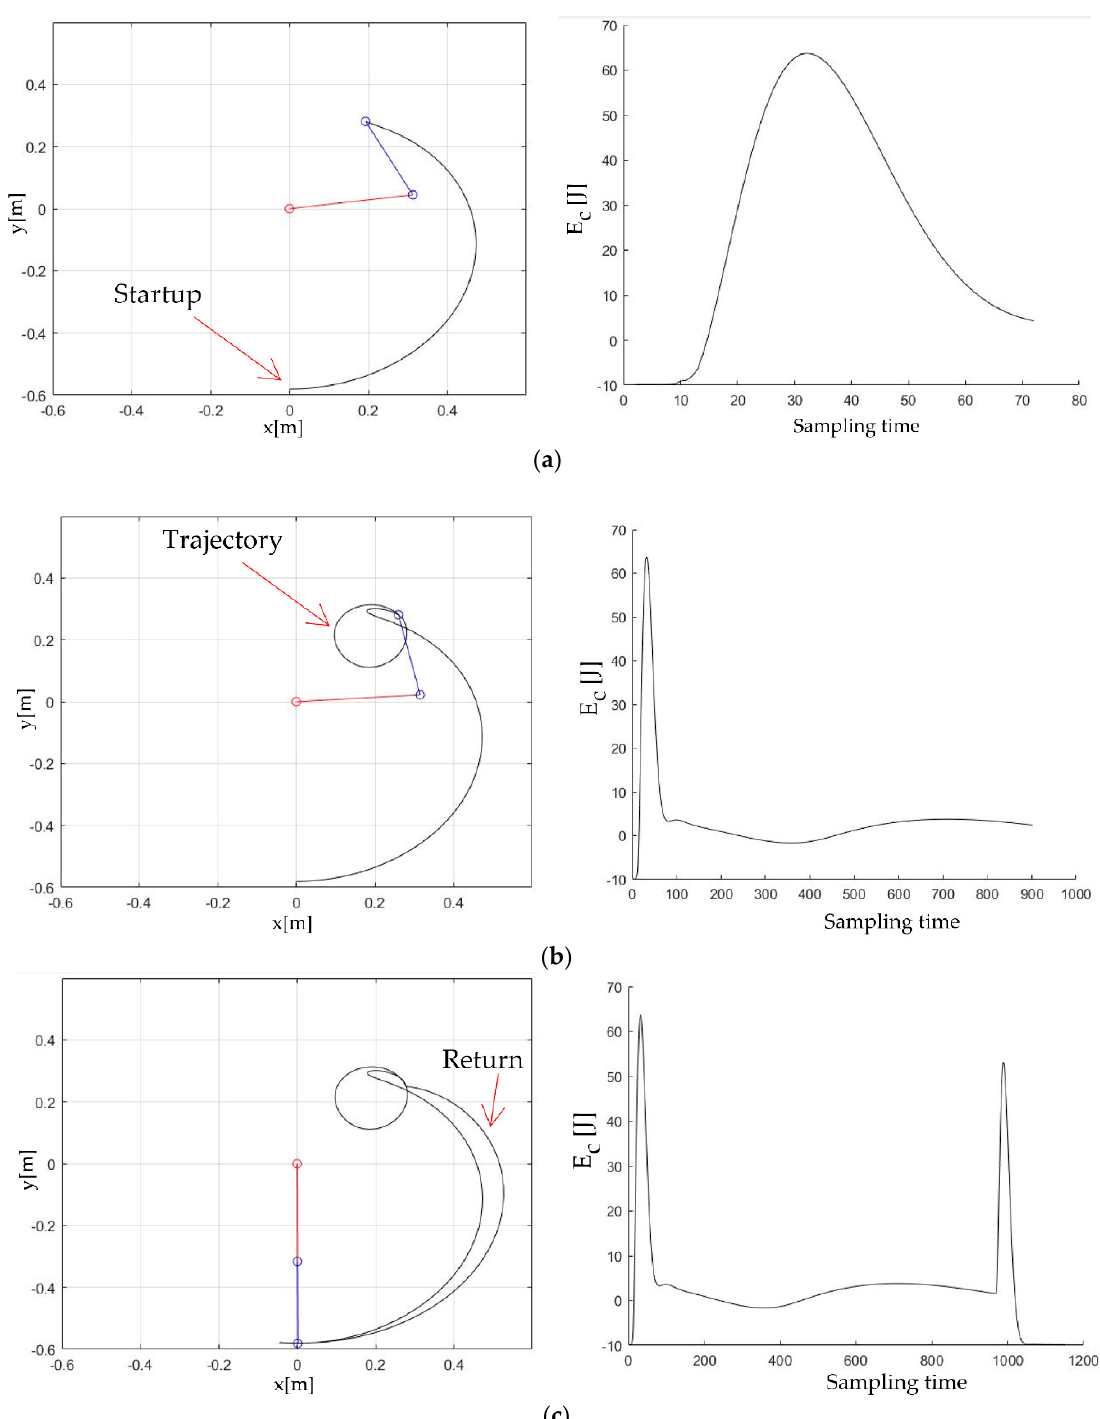
Figure 7. Simulation of the 3 states that allow generating the circular trajectory by implementing the PD-DGD-type control algorithm with gravity compensation: ( a ) startup, ( b ) trajectory, ( c ) return to startup.